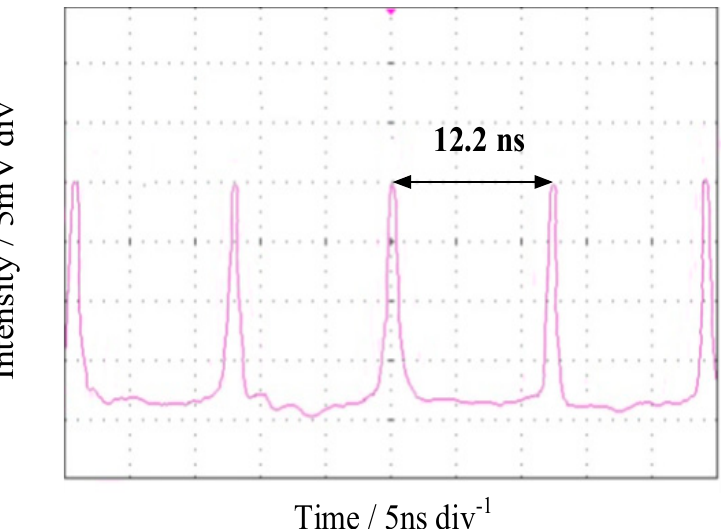
Figure 5. Pulse sequence wave-form of QML fiber laser .